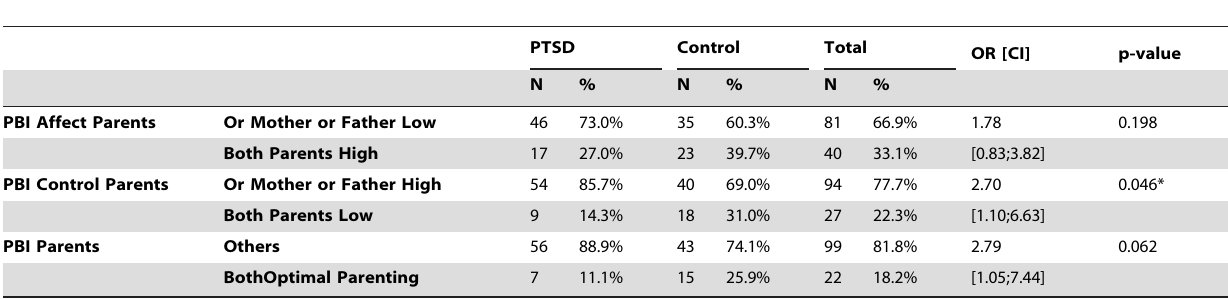
Table 3. The distribution of mothers and fathers of patients with PTSD and controls into the main bonding categories – optimal x dysfunctional parenting – defined by the PBI.